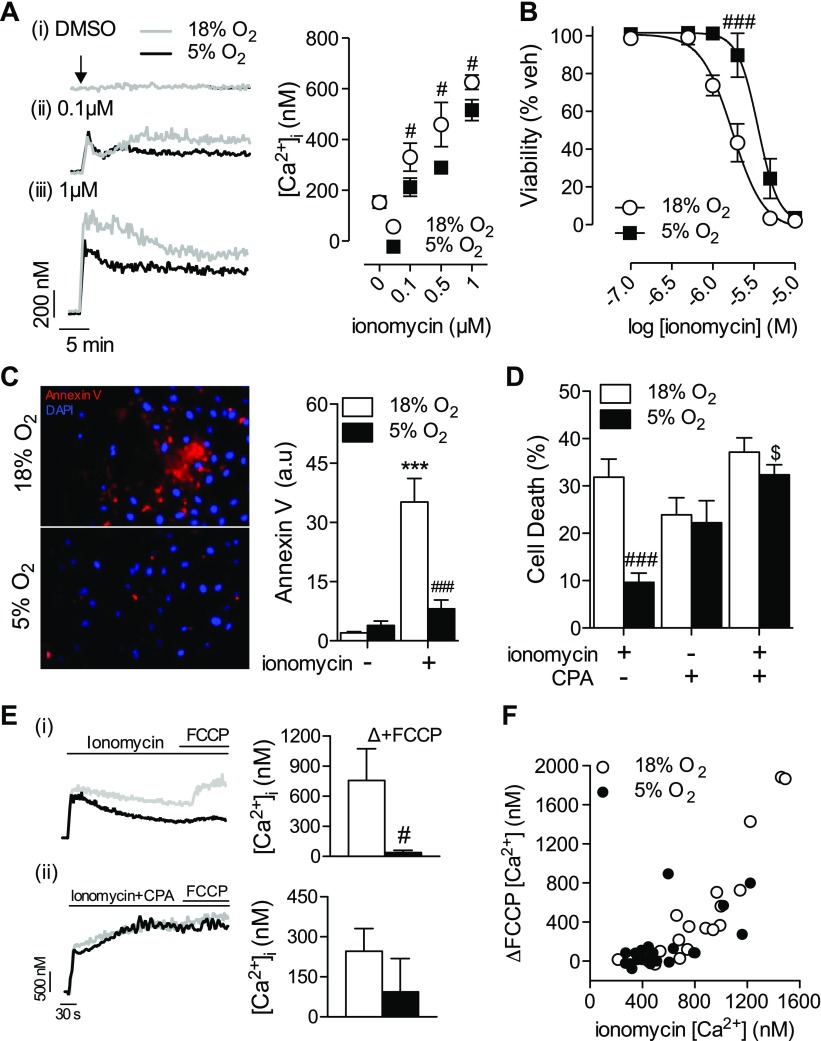
Ca2+ overload–induced cell death is reduced at 5% O2. HUVECs were cultured under standard (18%) or physiologic (5%) O2 levels and then stimulated with 0.1% DMSO (vehicle) or 0.1–10 µM ionomycin for 0.5–14 h. A) Ionomycin induced changes in [Ca2+]i. B) Cell death determined by MTT (2 h). C) Apoptosis determined by annexin V (14 h). D) Effects of SERCA inhibition with CPA (10 µM) in conjunction with ionomycin (0.1 µM, 14 h) on cell death. Data denote mean ± sem of measurements in 4–6 different donors. E) Cells were treated with ionomycin (1 µM) alone (i) or with CPA (ii) and then FCCP (5 µM) to release mitochondrial Ca2+. Representative traces are provided, and the mean ± sem of changes in [Ca2+]i after FCCP treatment in ionomycin with or without CPA-treated cells is shown. F) The ∆[Ca2+]i after FCCP treatment plotted against the initial plateau [Ca2+]i after ionomycin treatment. Spearman’s rank correlation analysis revealed a strong correlation between [Ca2+]i and FCCP-released Ca2+ at both 18 and 5% O2 (ρ = 0.91, P < 0.0001 and ρ = 0.62, P = 0.0015, respectively). #P < 0.05, ###P < 0.001 vs. 18% O2, $P < 0.001 vs. ionomycin alone, ***P < 0.001 vs. absence of ionomycin.